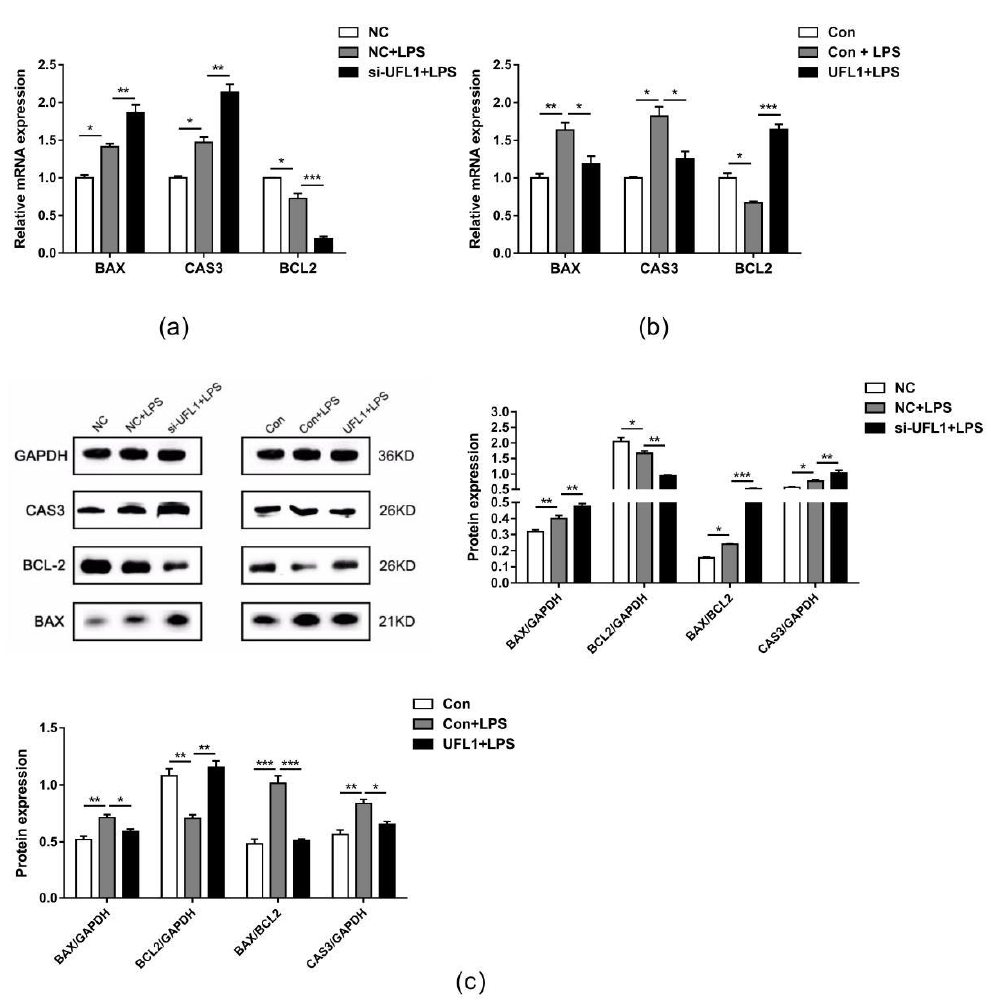
Figure 5. ( a ) Effect of Ufl1 siRNA on activity of Bax , Cas3 , and Bcl-2 in LPS-challenged bGCs. ( b ) Effect of Ufl1 overexpression on activity of Bax, Cas3 , and Bcl-2 in LPS-challenged bGCs. Data are